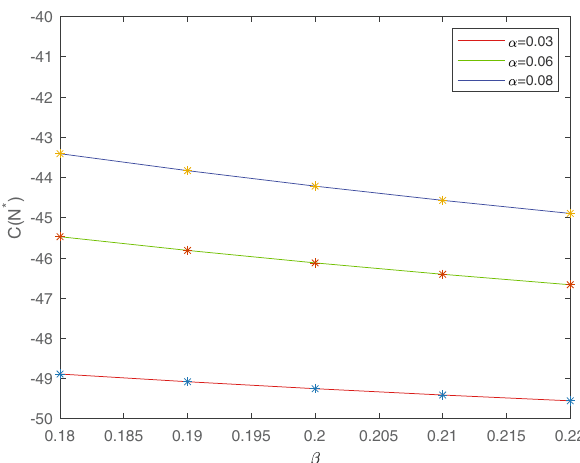
Figure 2: Comparison of the numerical results of ( ) C N and ( ) C N 2 .